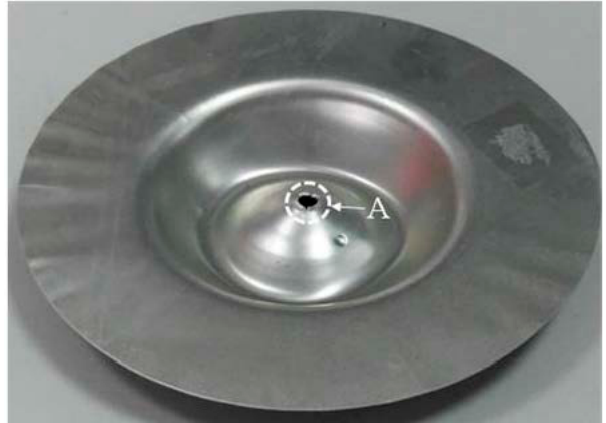
Metals 2018 , 8 , x FOR PEER REVIEW Figure 18. Photo of electromagnetic high-speed impaction fracture specimen. Figure 18. Photo of electromagnetic high-speed impaction fracture specimen.